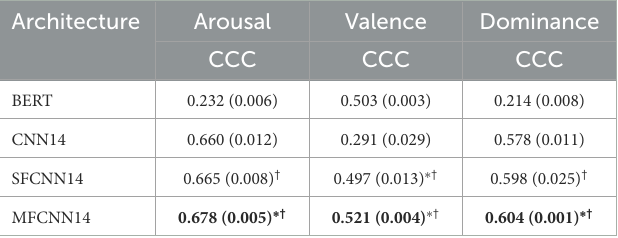
TABLE 3 CCC results for emotional dimension prediction using multi-task models on MSP-Podcast trained with a CCC loss. Architecture